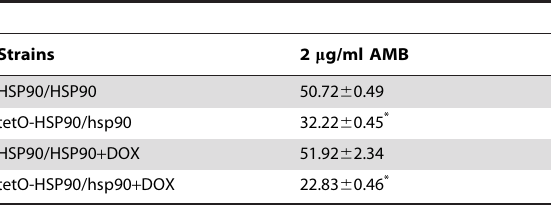
Table 5. Caspase activity of C. albicans cells after AA treatment 5 .